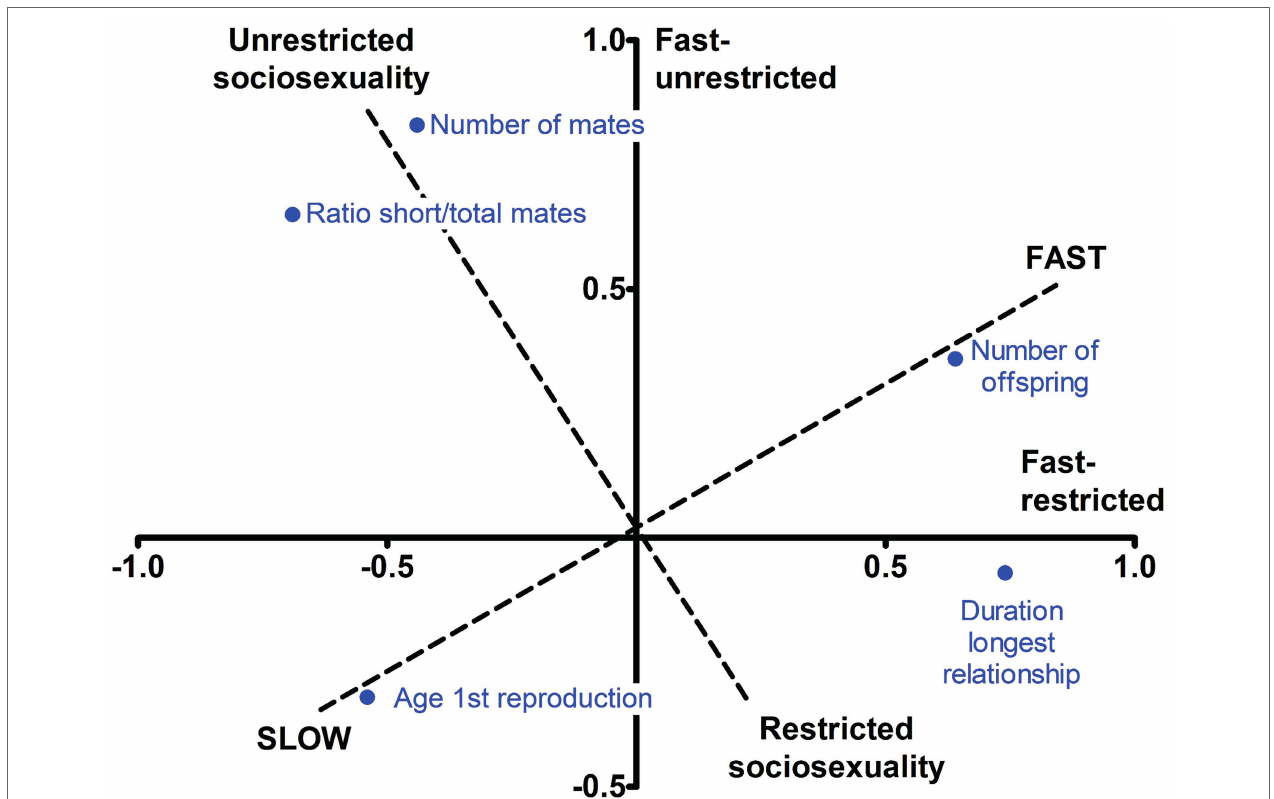
FIGURE 1 | Unrotated and varimax-rotated axes for reproductive LH